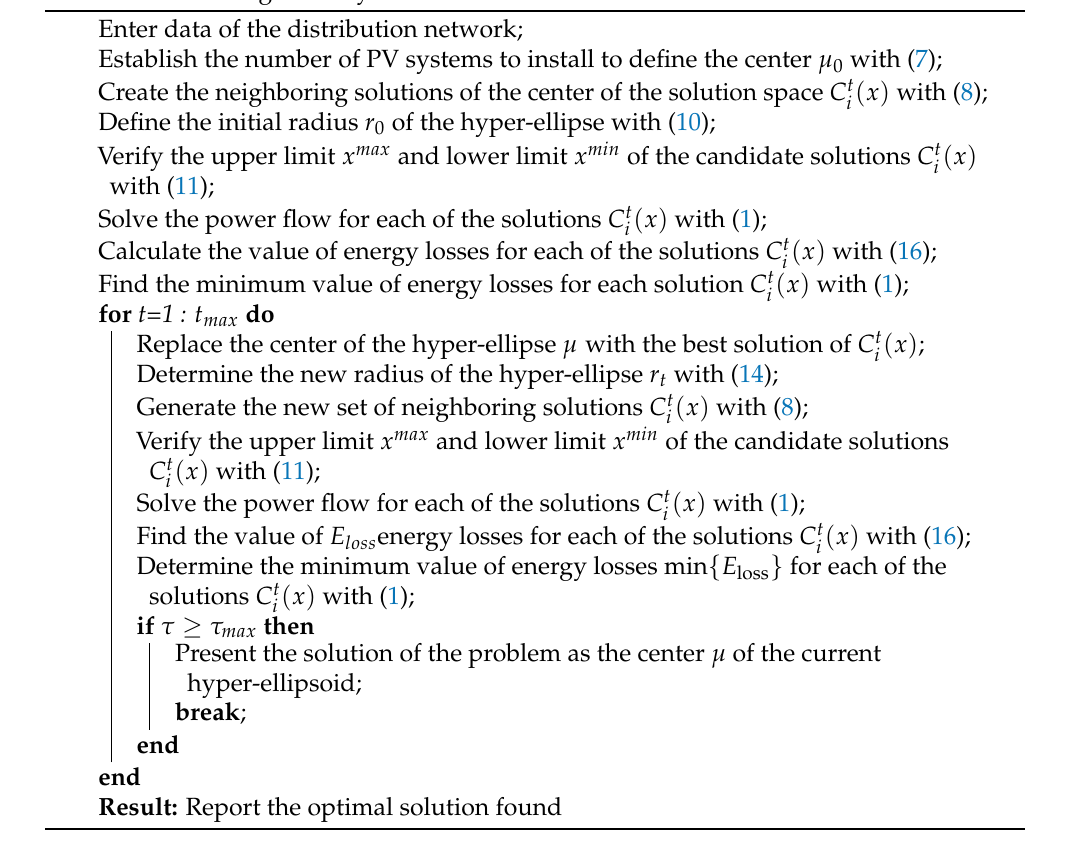
Algorithm 1: Implementation of the DCVSA algorithm for the optimal location and dimensioning of PV systems in distribution networks.